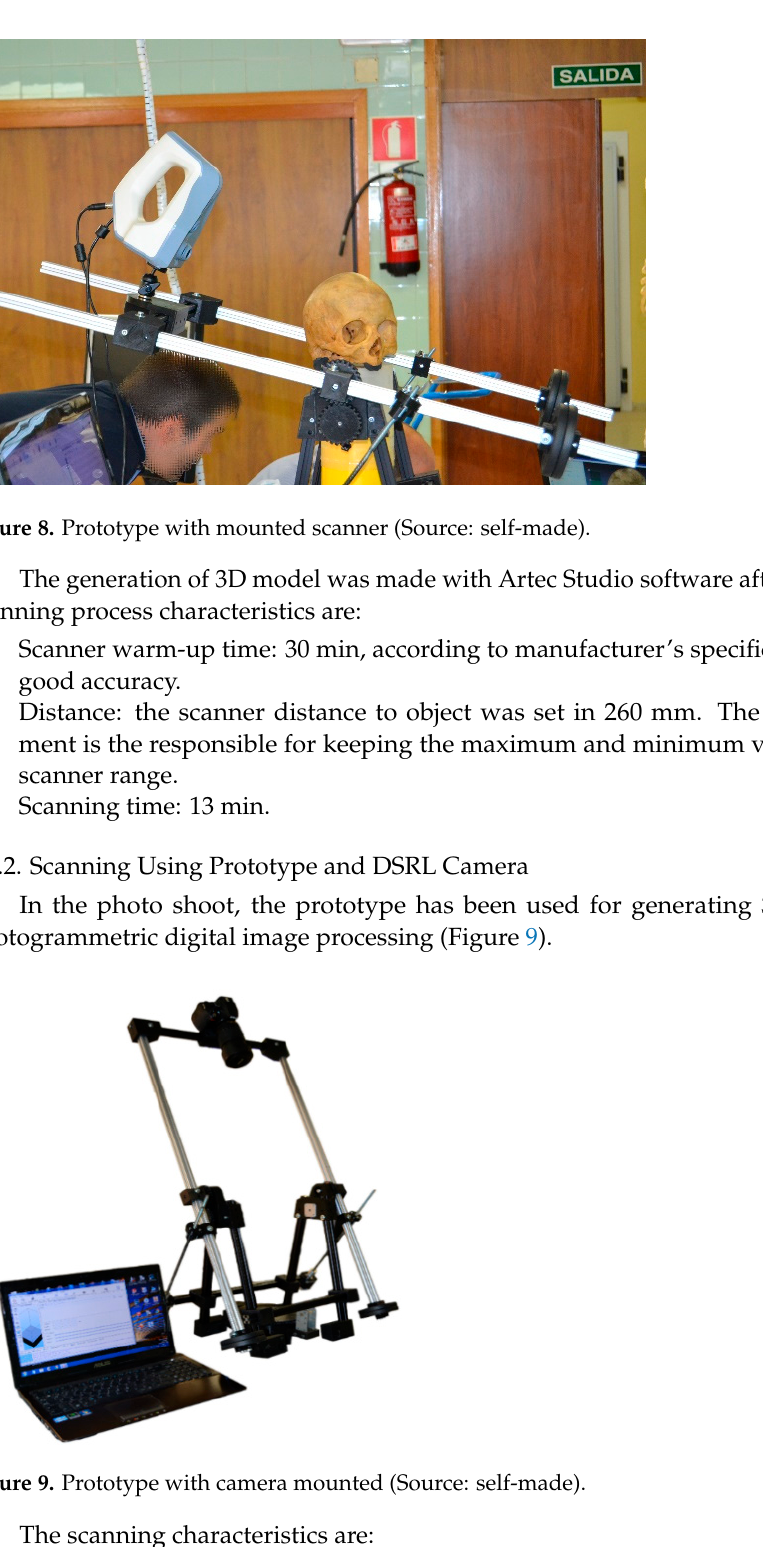
Figure 9. Prototype with camera mounted (Source: self-made).